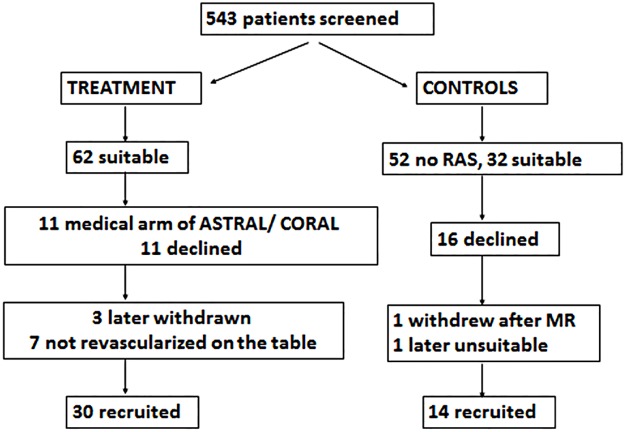
Summary of recruitment flow.